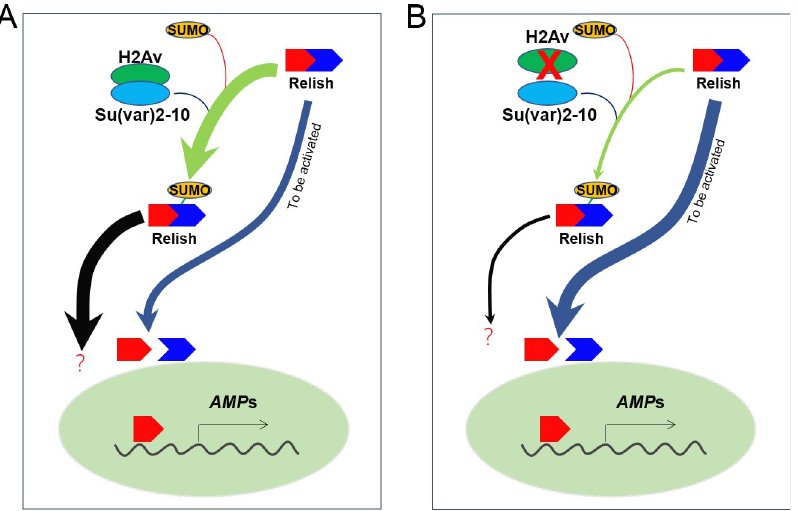
Fig 8. H2Av negatively regulates the IMD pathway to produce AMPs by enhancing Relish SUMOylation. Through interacting with Su(var)2-10, H2Av enhances the SUMOylation of Relish. SUMOylated Relish may not be cleaved upon immune challenge, thus decreasing the amount of cleavable Relish (A). When H2Av loses its function, the amount of SUMOylated Relish decreases correspondingly. Due to this, Relish without modification of SUMOylation is increased above normal levels, which is likely similar to the over-expression of Relish that occurs through genetic methods, and induces its activation by an unknown mechanism (B). Upon immune challenge, Relish that is not SUMOylated can be cleaved and activated by the conventional mechanism. Currently, the fate of SUMOylated Relish is